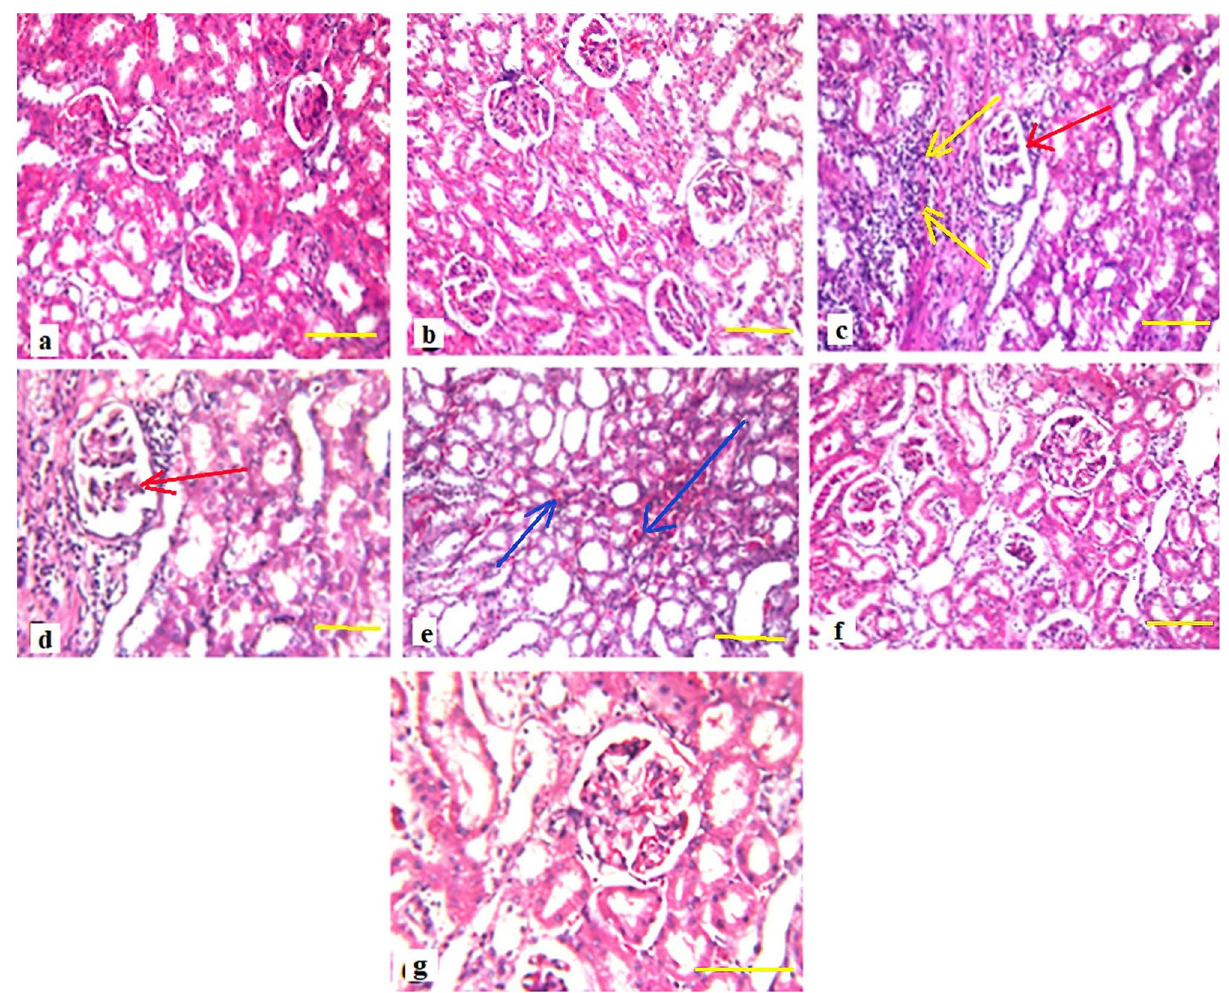
Figure 6. Light microscopy (LM) images showing the morphology of the normal sperms and their various defects; ( a ) normal kidney, ( b ) normal rats administered with the extract PsPc-3; ( c , d ) showing the degenerative change in the lining epithelium of some tubules at the cortex (red arrows) and focal inflammatory cells infiltration with fibrosis (yellow arrows) were detected in between the glomeruli and tubules at the cortex